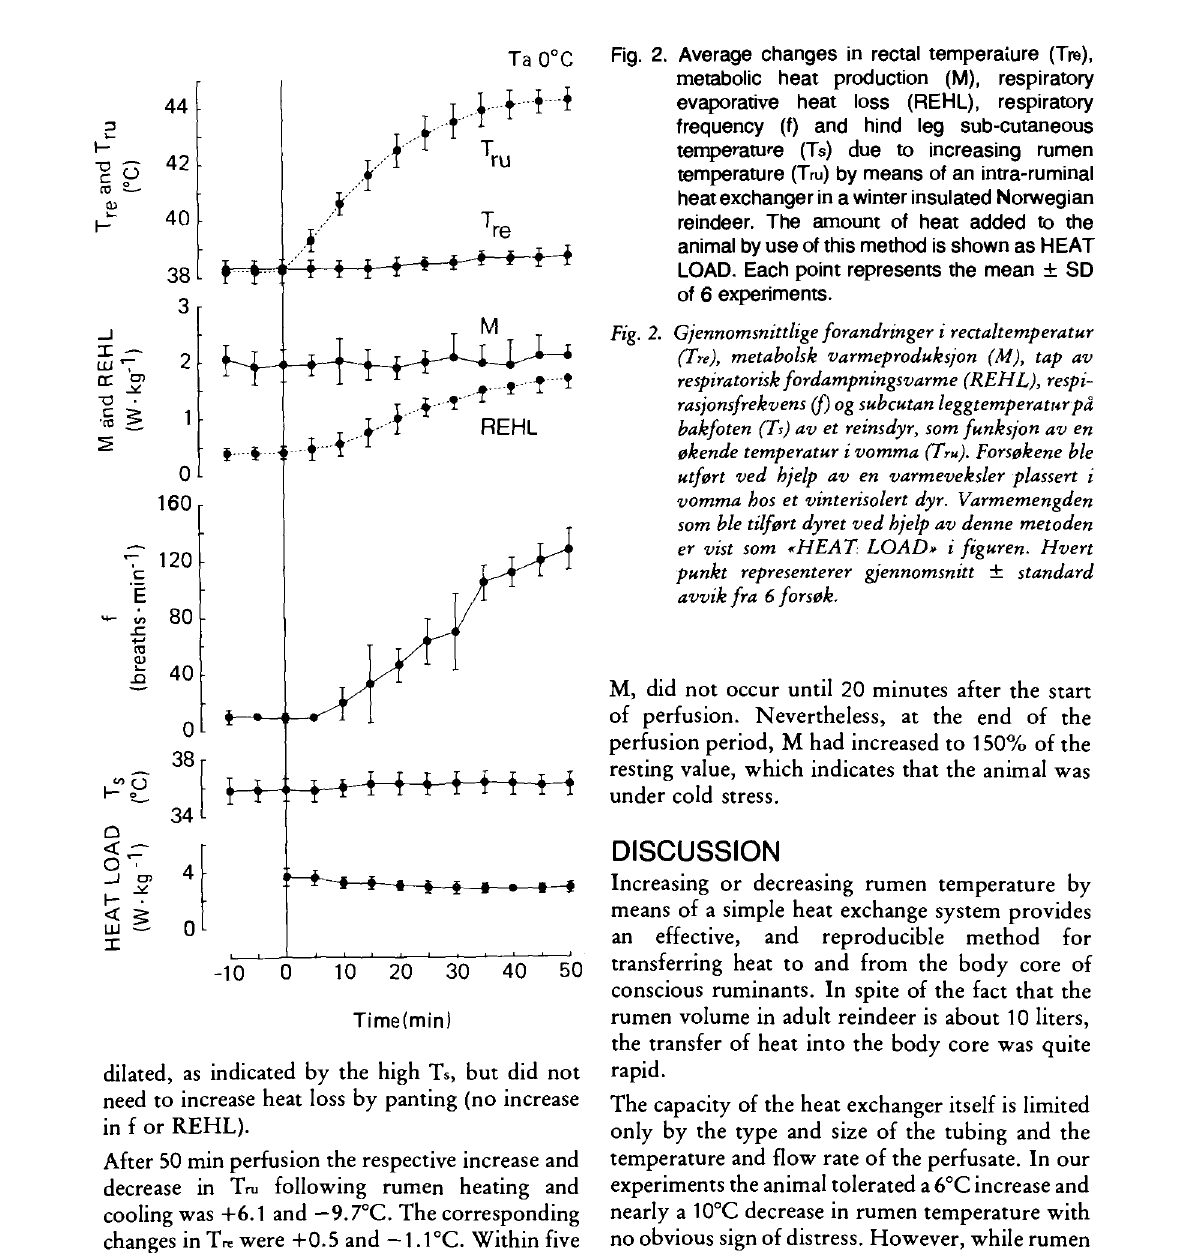
M, did not occur until 20 minutes after the start of perfusion. Nevertheless, at the end of